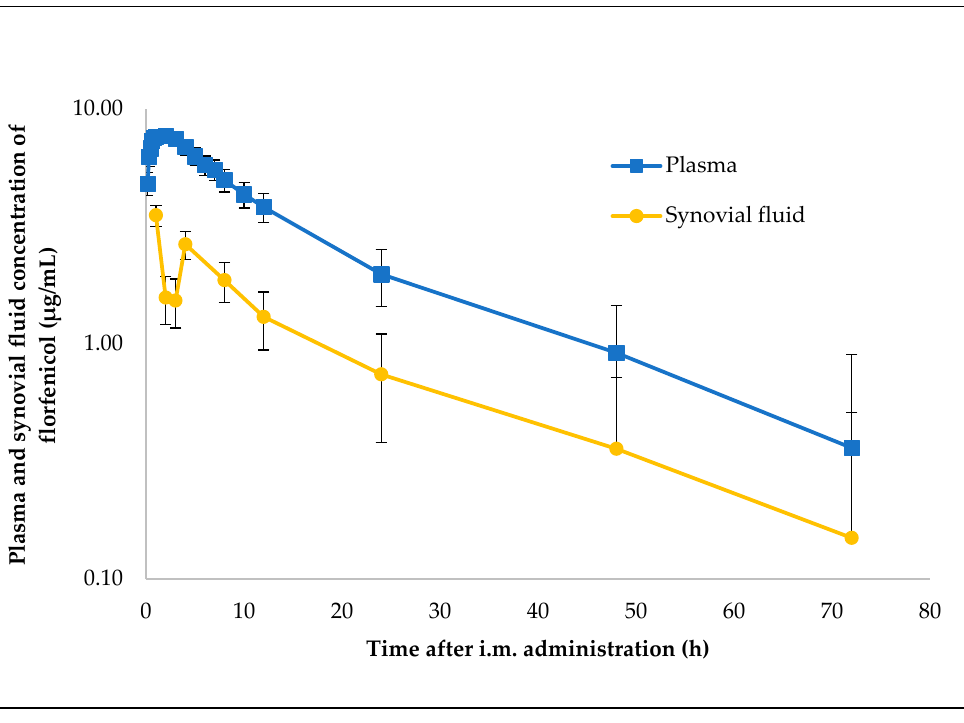
Figure 1. Semi-logarithmic plot illustrating the concentration–time curve of florfenicol in plasma and synovial fluid samples of pigs after a single i.m. administration of 30 mg/kg bw (n = 8).